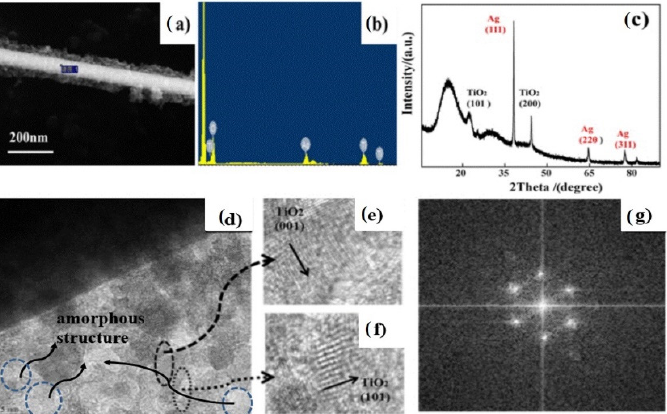
Figure 2. SEM image ( a ); EDS ( b ); XRD pattern ( c ) of a single root AWT obtained from a 12-h hydrothermal reaction; TEM ( d ) of the AWT obtained after a 1-h calcined process; the corresponding lattice fringes ( e ) and ( f ); the corresponding electron diffraction patterns (EDP) ( g ).